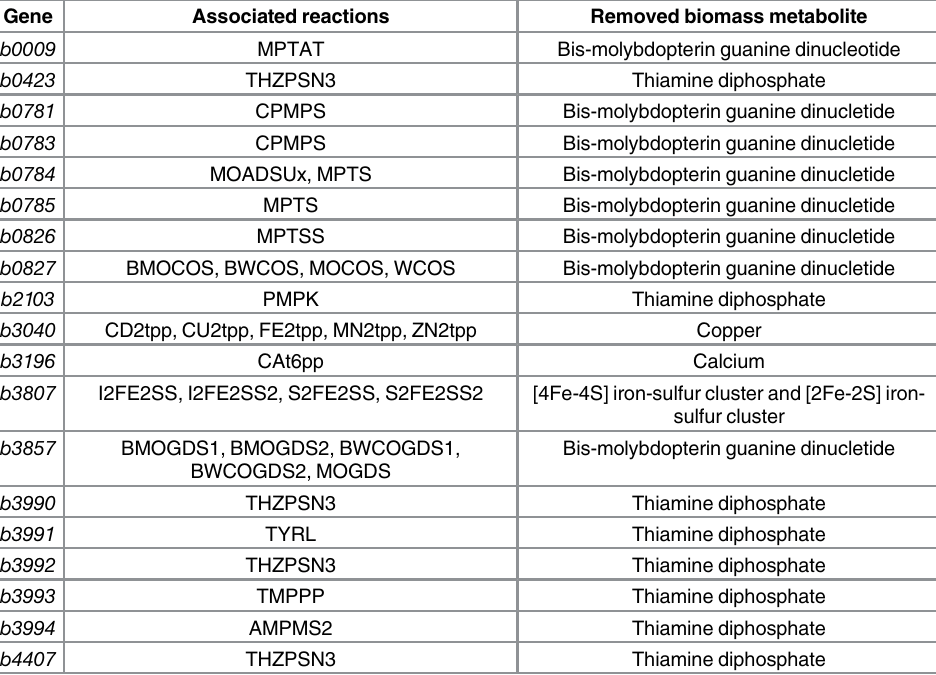
FPp related to the alternative pathway converted the TPp into a FNp that was then rescued by the inclusion of the newly identified isoenzymes. Solving FNp: Removing biomass components. Removing metabolites from the biomass reaction can convert FNp to TPp, as all genes involved in the production (or, if the metabolite was a product of the biomass reaction, consumption) of a metabolite become unessential. G LO- BAL F IT suggested the removal of six metabolites from the biomass reaction, thereby resolving 19 FNp (Table 5). For example, removing Bis-molybdopterin guanine dinucleotide from the bio- mass reaction converted eight genes involved in the synthesis of this metabolite from essential to non-essential genes. By removing Bis-molybdopterin guanine dinucleotide and Thiamine diphosphate, two TNp become FPp (b0417 and b2530); however, because these two changes also correct 16 FNp, the overall accuracy was strongly increased. G LOBAL F IT further indicated the removal of calcium and copper from the biomass, which was also suggested by the BioMog algorithm based on E . coli growth data on different media [16]. Calcium is essential for proper functioning of E . coli chemotaxis [32]. However, Table 5. Removal of biomass components from the E . coli model suggested by GlobalFit to remove